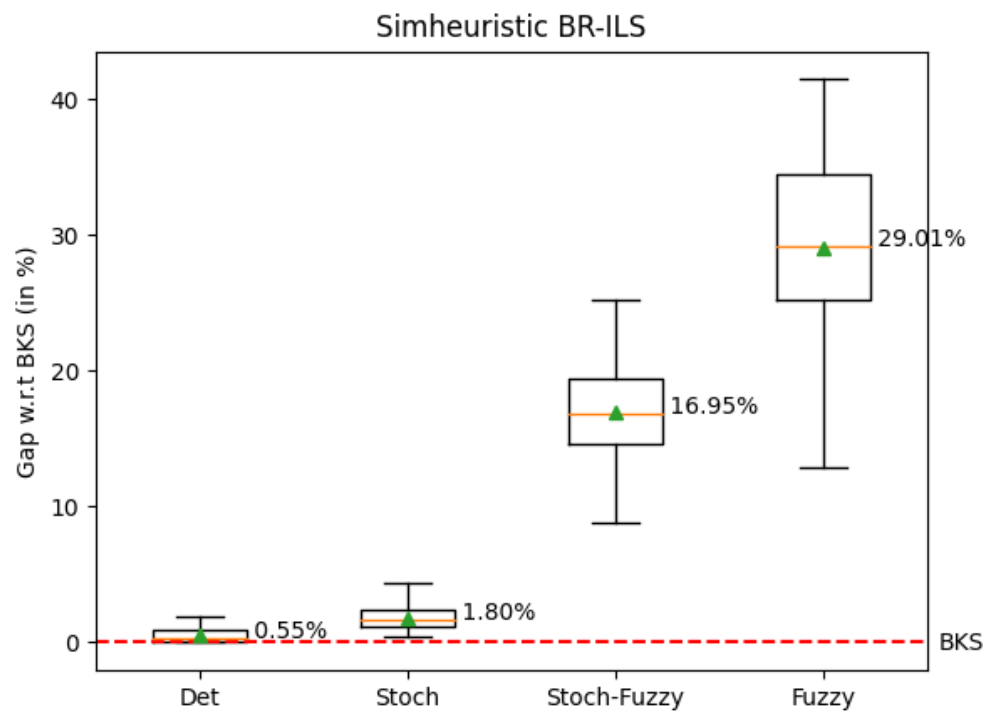
Figure 6. Percentage gaps of our SimBR-ILS approach w.r.t. deterministic BKS